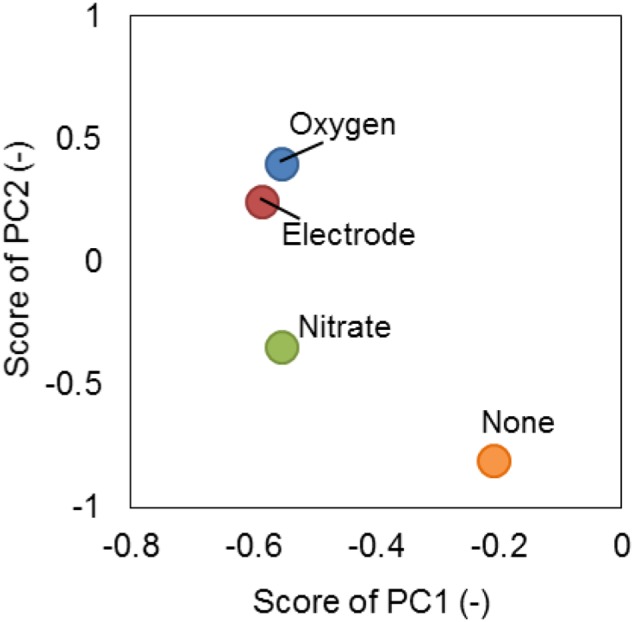
Principle compartment analysis (PCA) on the basis of FTIR spectrum of SMP produced by strain S05 cultured at sufficient supply of different external electron acceptors.